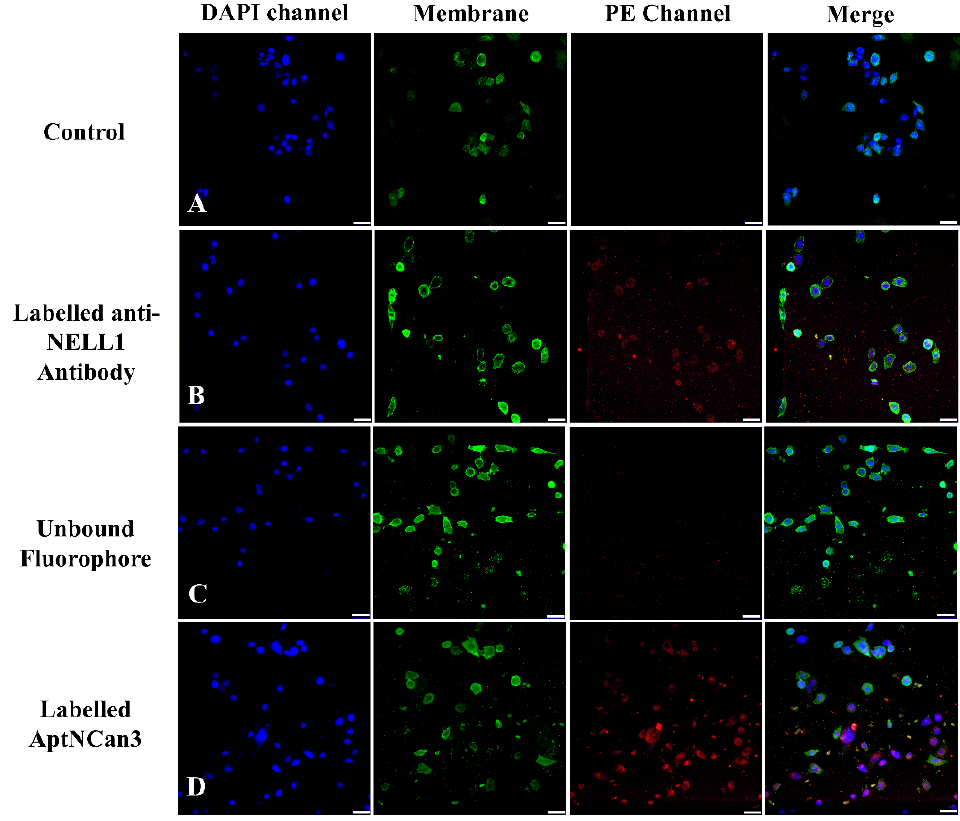
Figure 7. Fluorescence confocal imaging of anti-NELL1 aptamer-specific binding in RH30 sarcoma cells. The RH30 sarcoma cells were incubated overnight with ( A ) Non-labeled AptNCan3; ( B ) CF555-labeled anti-NELL1 antibody; ( C ) Unbound PE staining; and ( D ) PE-labeled AptNCan3. The cells were then thoroughly washed and fixed with 4% PFA. Scale bar, 50 µm.